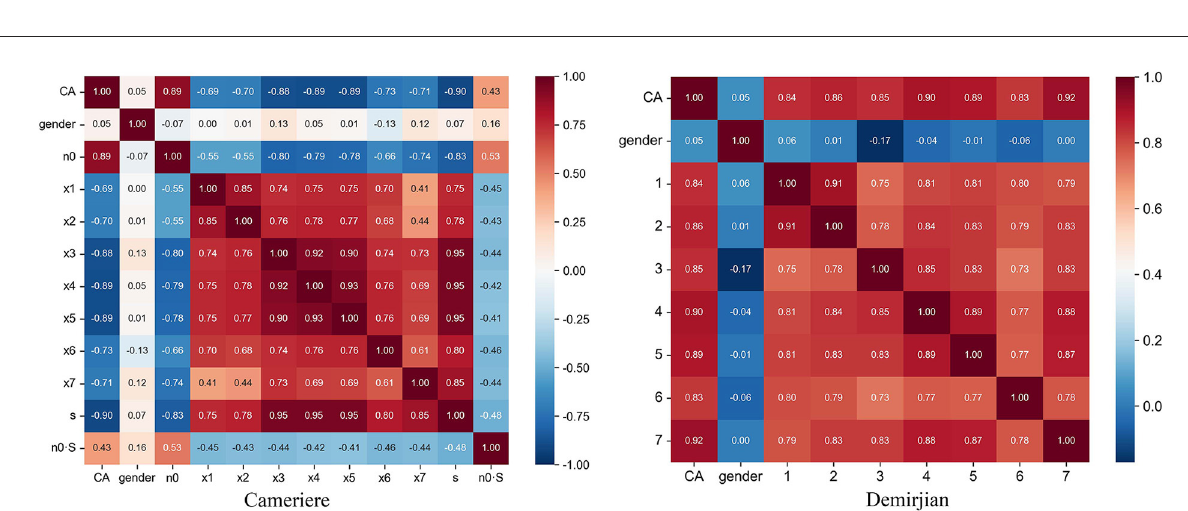
the corresponding absolute